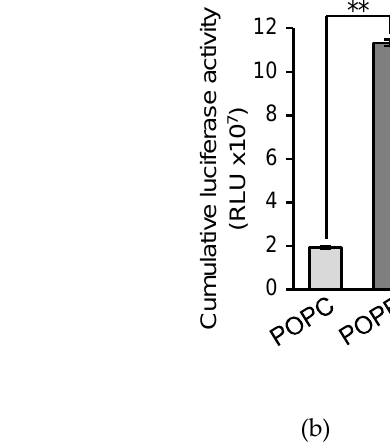
Figure 2. Transfection activity of the LNP ssPalm . ( a ) Effects of phospholipids and PEG-lipids on the mRNA transfection activity. the LNP ssPalm with the composition of ssPalmO-Phe-P4C2/DOPC/cholesterol = 52.5/7.5/40 or ssPalmO-Phe- P4C2/POPE/cholesterol = 50/15/30 were prepared with additional 0.375% to 3% of DMG-PEG2000 ( n = 3). Statistical analyses were performed by the Kruskal–Wallis test followed by Scheffe test, **; p < 0.01 against POPE with 0.375% PEG, ##; p < 0.01 against POPE with 0.75% PEG. ( b ) Effects of the head group of phospholipids on the mRNA transfection activity. The phospholipid content of the LNP ssPalm was replaced by the POPC to compare the effects of the head group of phospholipids ( n = 3). Statistical analysis was performed by the student- t’s test, **; p < 0.01. Table 1. Particle properties of the LNPs in Figure 2.